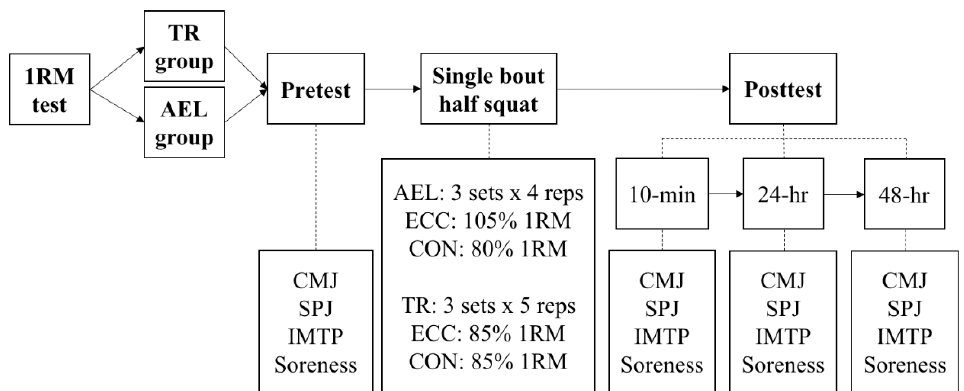
Figure 1. Study design. 1RM = one repetition maximum; AEL = accentuated eccentric loading; TR = traditional resistance training; reps = repetitions; ECC = eccentric phase; CON = concentric phase; CMJ = countermovement jump; SPJ = spike jump; IMTP = isometric mid-thigh pull.